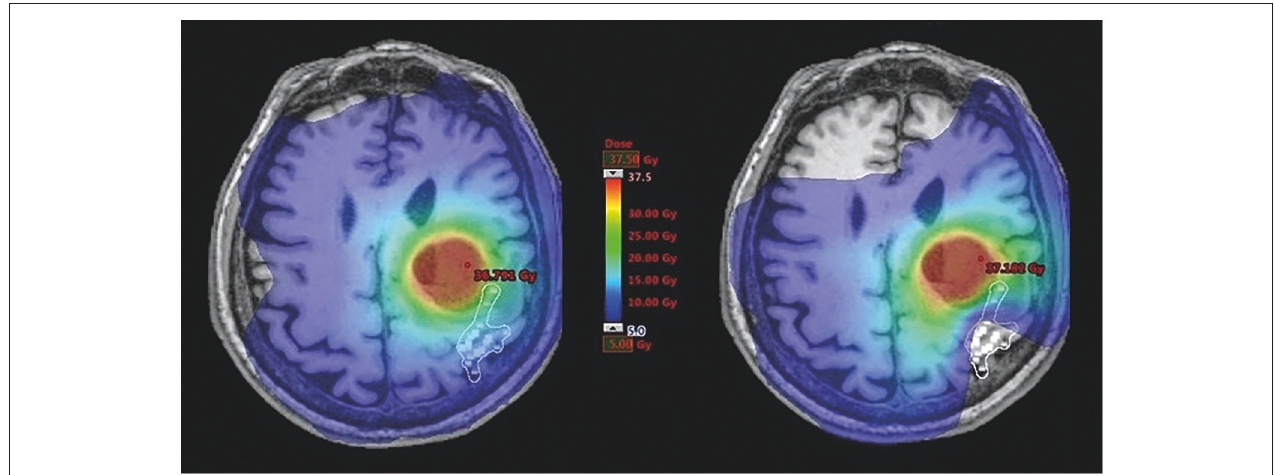
FIGURE 2 | Dose distribution within motor maps. This figure illustrates radiotherapy (RT) planning in one exemplary patient with a brain metastasis affecting the left central region. The navigated transcranial magnetic stimulation (nTMS) motor-positive points (white squares) are shown on respective contrast-enhanced, T1-weighted magnetic resonance imaging (MRI) and were contoured as an organ at risk (OAR) in the RT plan. Dose distributions covering the range of 5–37.5Gy are visualized in color-wash mode showing high doses in red and low doses in blue colors. Constraining dose to nTMS motor maps resulted in a shift of dose distributions to lower